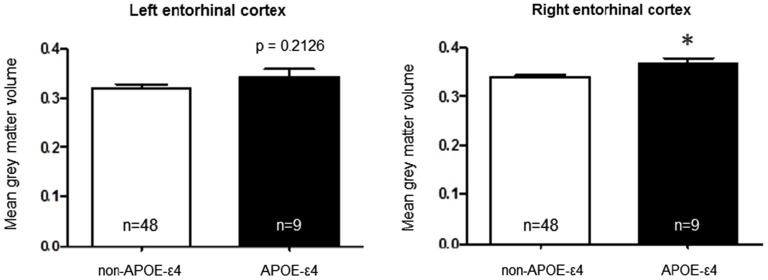
Apolipoprotein E-ε4 AD risk genotype is associated with greater right entorhinal cortex volume. A two-tailed t-test demonstrates that when participants are grouped based on APOE status alone, the risk allele (APOE-ε4) is associated with higher right entorhinal cortex volume compared to the non-risk alleles t(55) = 2.29, p = 0.0259. (*p < 0.05, n = 48 non-APOE-ε4 carriers, n = 9 APOE-ε4 carriers).